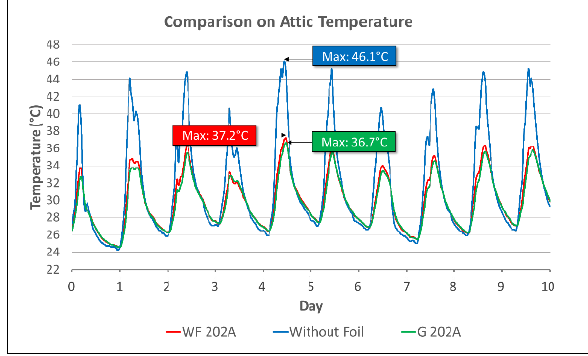
Figure 13: Attic air temperatures for 10 days